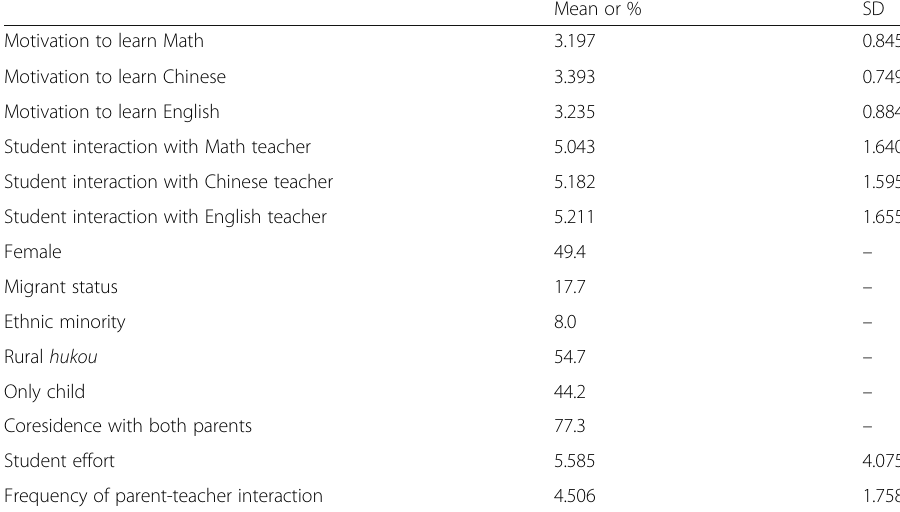
Table 1 Descriptive statistics of student sample ( N = 17,284)